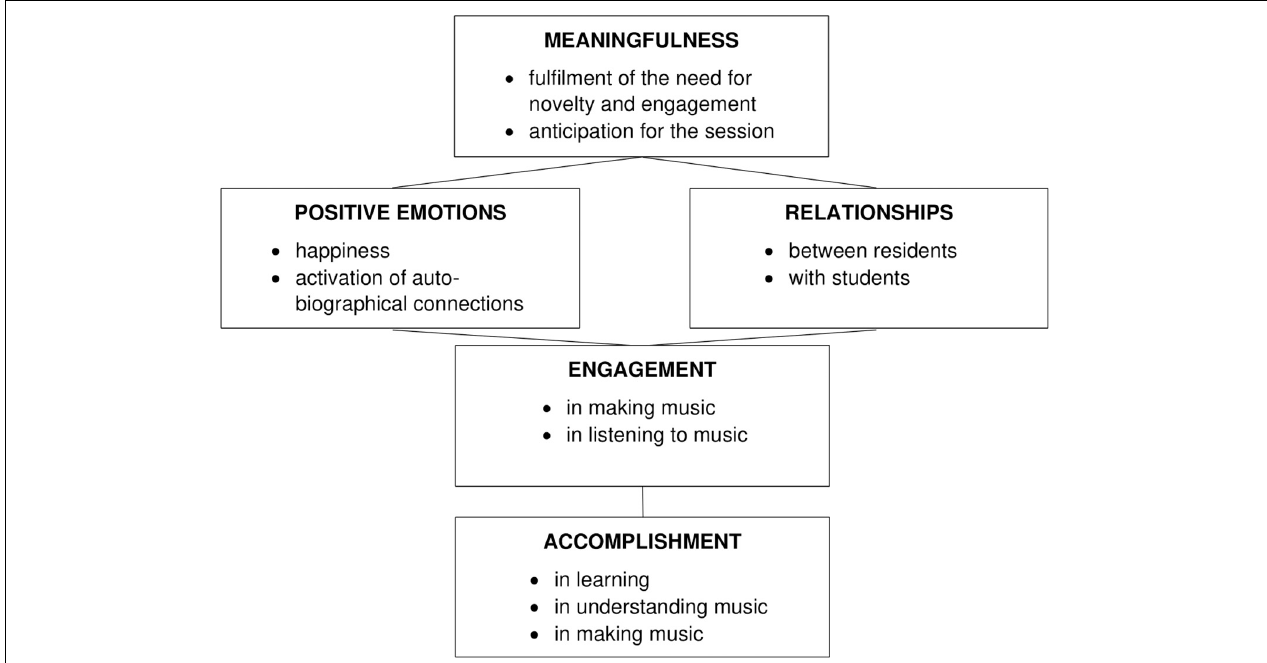
FIGURE 2 | Relationships between the results and the five dimensions of PERMA